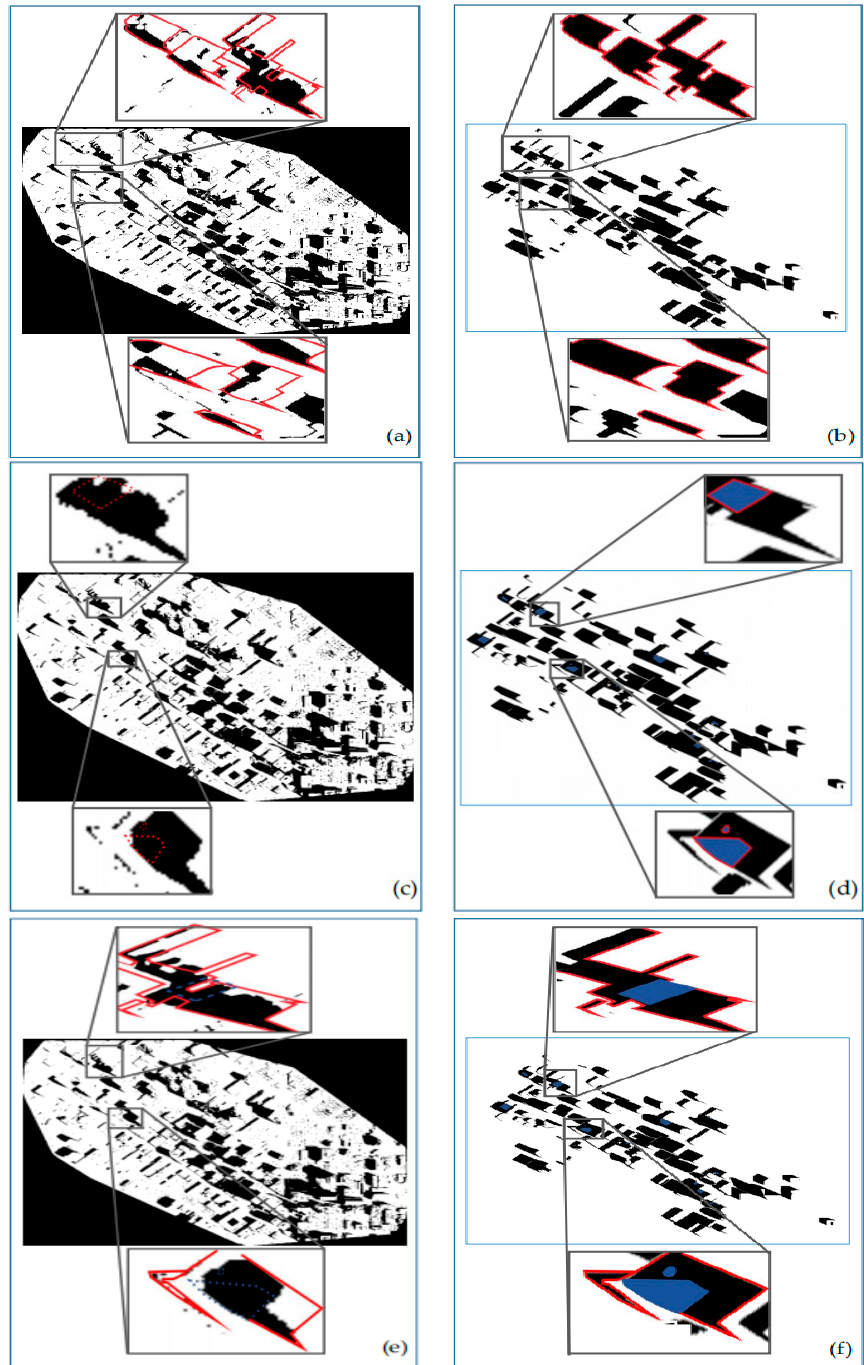
(3) Comparison of Figure 16e with Figure 16f: Figure 16e uses the traditional shadow detection method based on features of the shadow to simultaneously detect the shadows of building on the roofs and on the grounds. The result shows that the proposed method can not only greatly improve the integrity of the detection results, but also can simultaneously detect the shadows of building on the roofs and on the grounds.